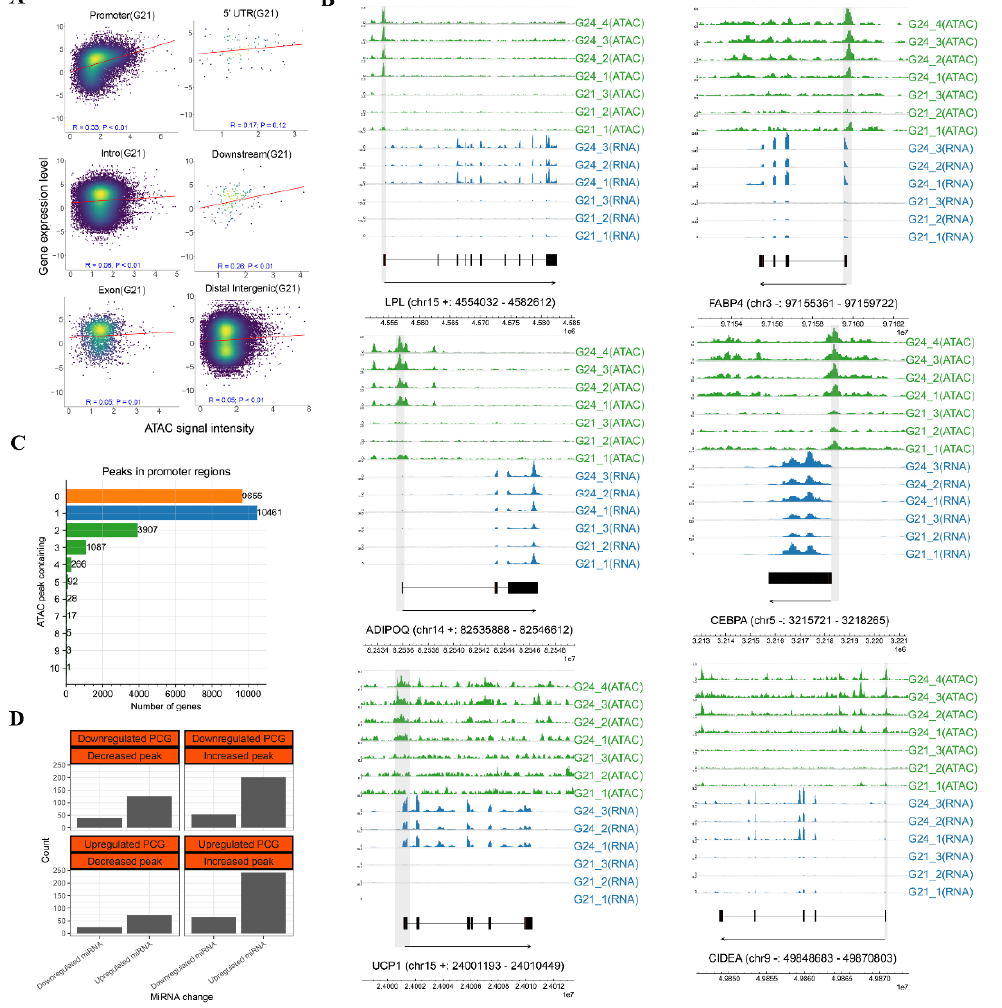
Figure 5. Integrated analysis of chromatin accessibility, miRNAs, and gene expression during FBAT development in rabbits. ( A ) Gene element-based correlation analyses between peak intensity and gene expression. The X -axis represents the log-scaled CPM values of the ATAC-seq peaks and the Y -axis represents the log-scaled TPM values of the corresponding nearby genes. R is Pearson’s correlation coefficient and P is the significance test for the correlation coefficient. ( B ) ATAC-seq (green) and RNA-seq (blue) tracks of key BAT genes. Gene exons are marked in black. Gene information is marked by “gene name (chromosome strand: start–end)”. The location of differential peaks is shadowed in grey. See also in the below tracks. ( C ) The number of genes containing different numbers of peaks in the promoter regions. The orange, blue, and green bars show the zero peak, single peaks, and double/multiple peaks for a gene, respectively. ( D ) Numbers of genes that were regulated by both chromatin accessibility and miRNAs.